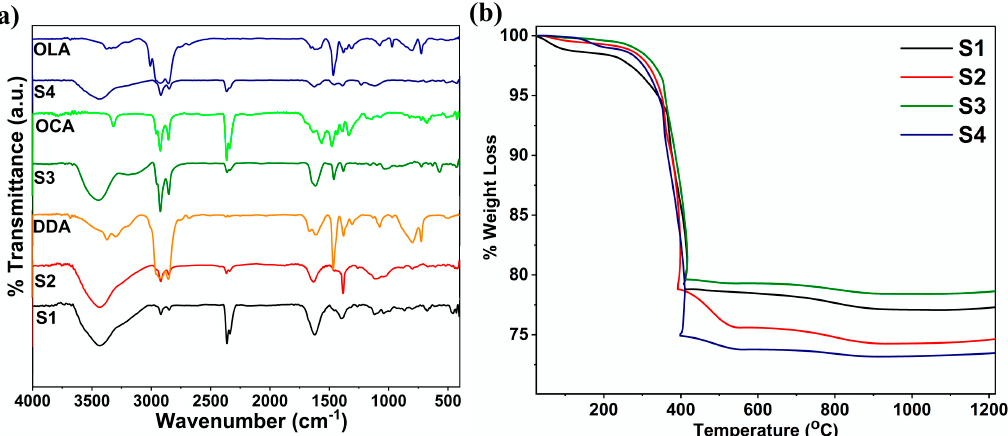
Figure 2. ( a ) IR and ( b ) TGA graph of SnS 2 nanoparticles synthesized in the absence and presence of capping agent by thermal decomposition method.